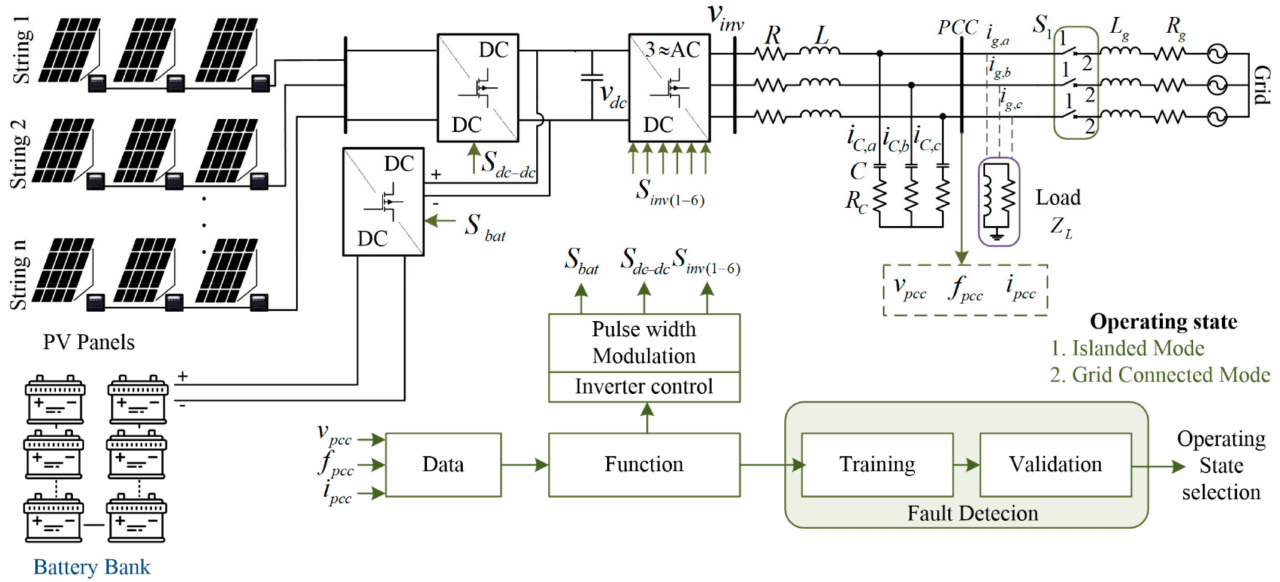
Figure 9. Overview of grid-connected inverter